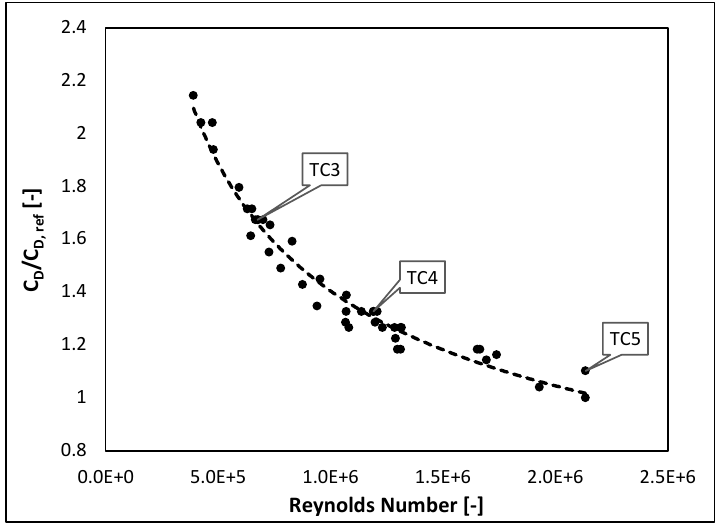
Figure 10. Calculated drag coefficient vs. Reynolds number for different steam turbine last-stage blades—values per blade. C D,ref is the minimal drag coefficient found.